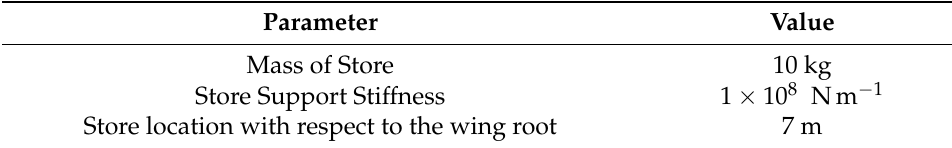
Table 4. Numerical values of the store.